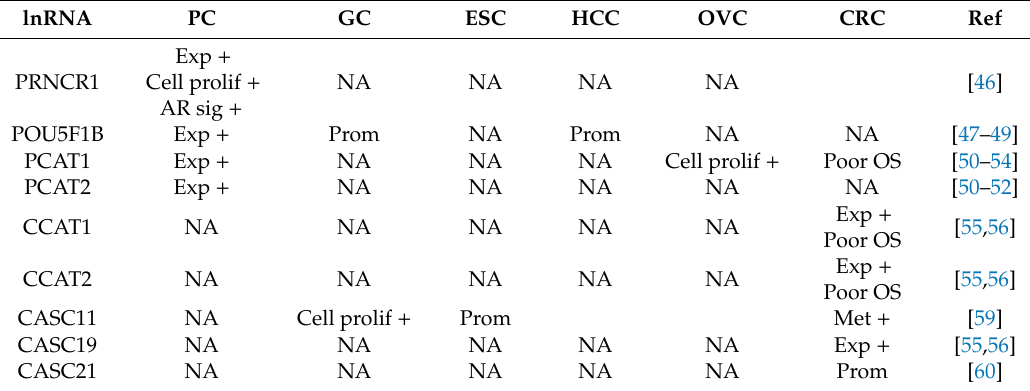
Table 1. Association of lnRNA of the 8q24.21 gene desert with